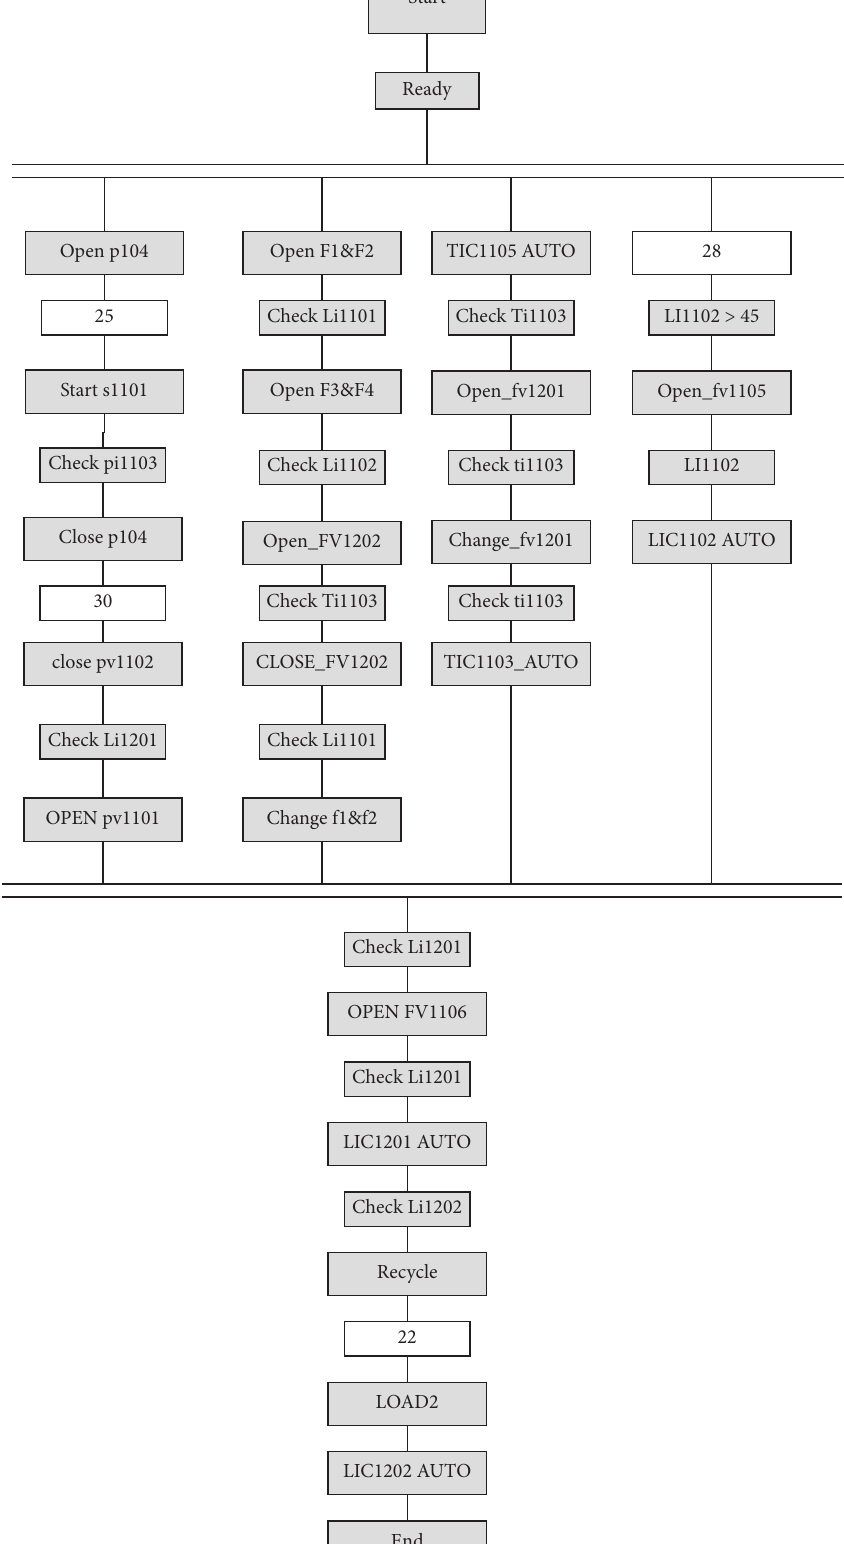
Figure 4: SFC driving sequence